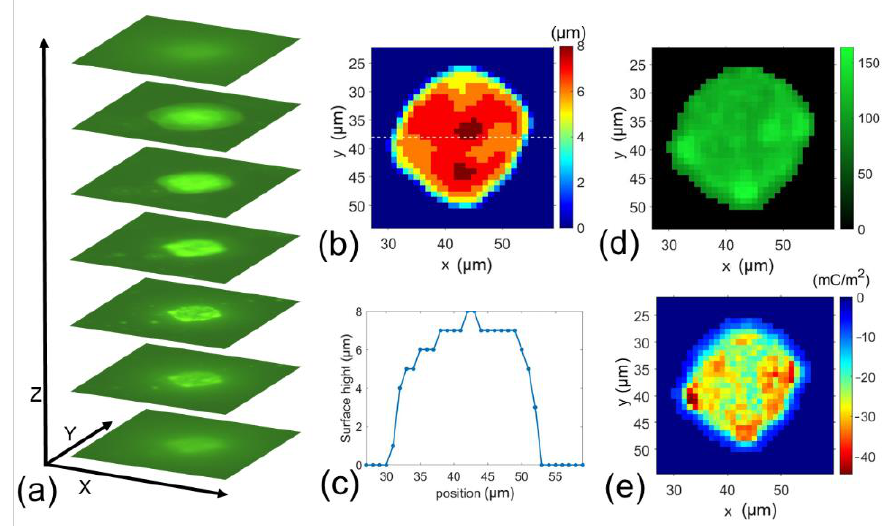
Figure 5. Typical measurement results of surface charge mapping of a Hela cell. ( a ) Z-stack images, ( b ) surface height mapping, ( c ) the surface height profile at the centerline of the cell along X-direction, ( d ) fluorescent intensity distribution, and ( e ) cell surface charge mapping.